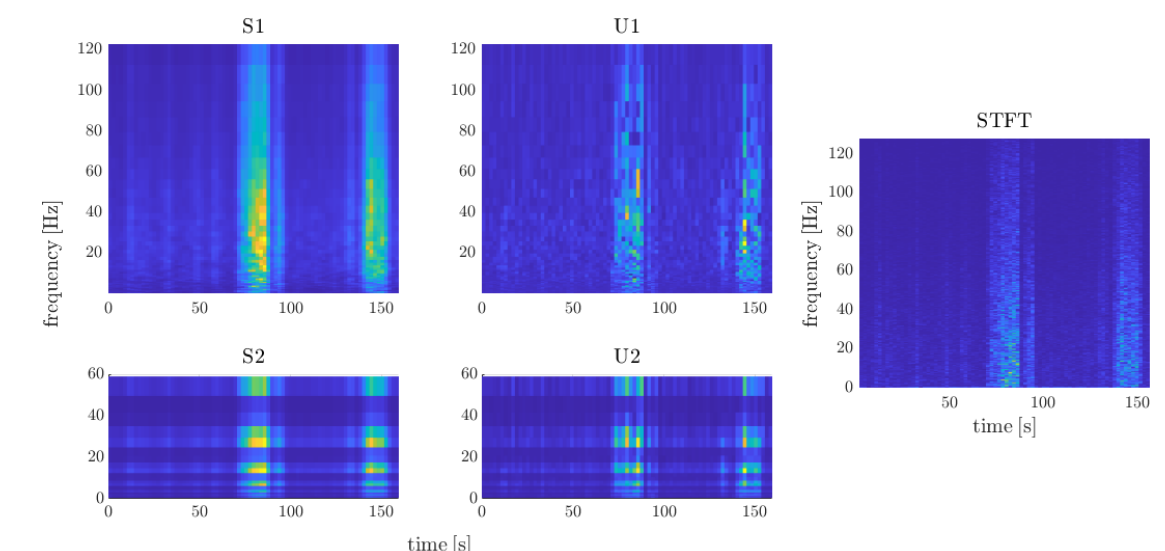
Figure 3. Output of the scattering spectrum transform ( S 1 , U 1 , S 2 , U 2 ) and short-time Fourier transform for electromyogra- phy (EMG) signal registered during a painful therapy. All of the values are normalized to the 0–1 range. Various energy distribution between transforms can be observed in subbands. Because scattering transform assumes a decreasing number of voices per octave, the time resolution increases in the following layers (see separable frames in U 2 at high energy around 30 Hz